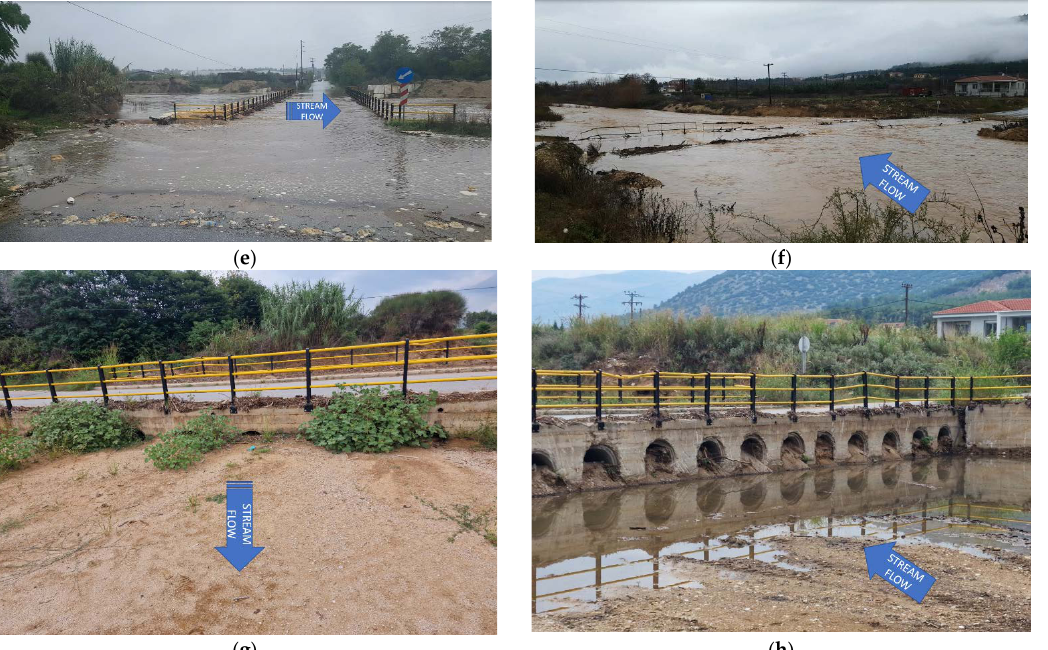
Figure 10. The Kallifitos torrent: ( a ) a field of view from the bed of the excavated material on 13 October 2020, ( b ) a field of view from the bed of the excavated material on 2 June 2022 (tire tracks are also visible), ( c ) a field of view from the bed of the deposition material on 8 February 2021, ( d ) a field of view from the bed of the deposition material on 5 November 2020, ( e ) a field of view from the road of the flooded area on 16 October 2021, ( f ) a field of view from the right bank of the flooded area on 12 January 2021 (the metal railings were destroyed), ( g ) a field of view from the bed of the deposition material at the bridge’s culverts on 24 August 2022 downstream from bridge ( h ) a field of view from the bed of the deposition material at the bridge’s culverts on 24 August 2022 upstream from